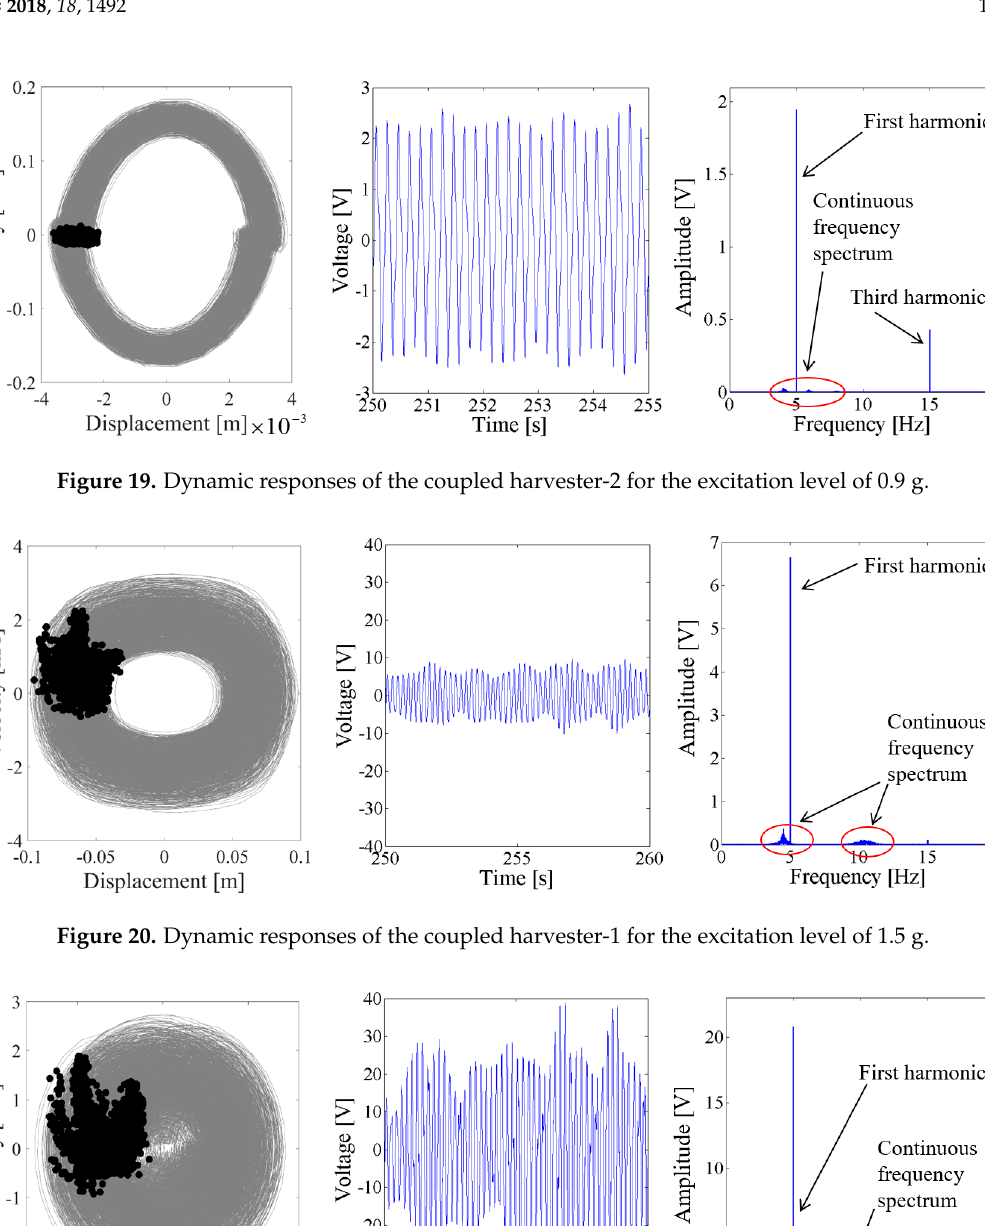
Figure 18. Dynamic responses of the coupled harvester-1 for the excitation level of 0.9 g.